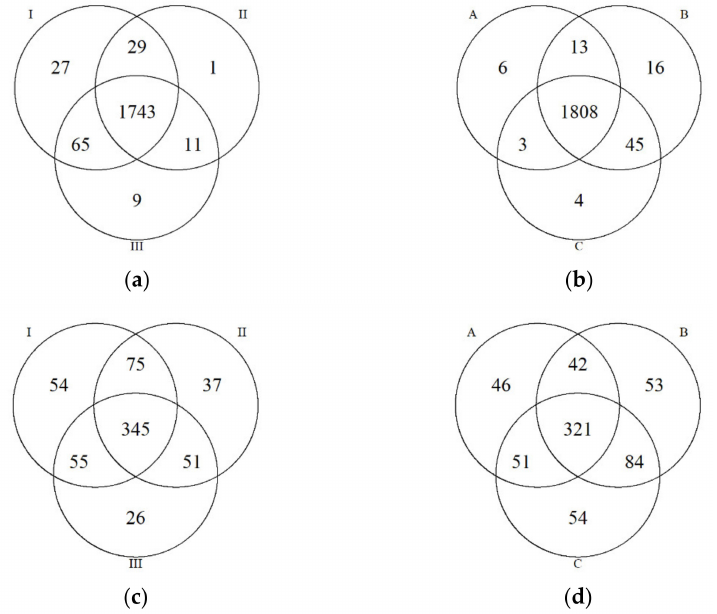
Figure 2. Venn diagram showing the unique and shared OTUs obtained from MiSeq sequencing. Bacterial OTUs in soil of black locust ( a ) and poplar ( b ), fungal OTUs in soil of black locust ( c ) and poplar ( d